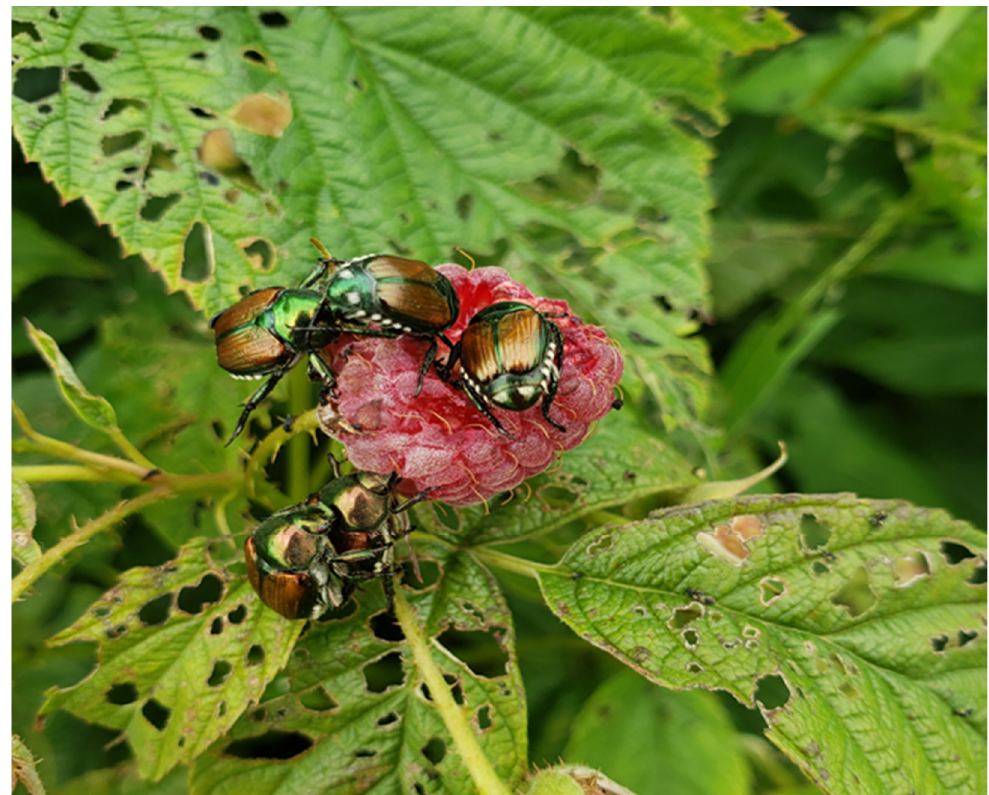
Figure 1. Adult P. japonica feeding injury on raspberry foliage and presence on primocane (autumn) raspberry fruit, Rosemount, MN, 2018 (A.G. Toninato, Univ. of Minnesota).